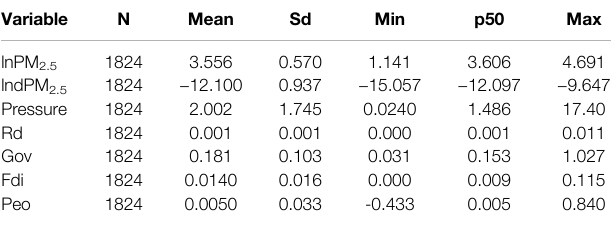
TABLE 1 | Descriptive statistics of